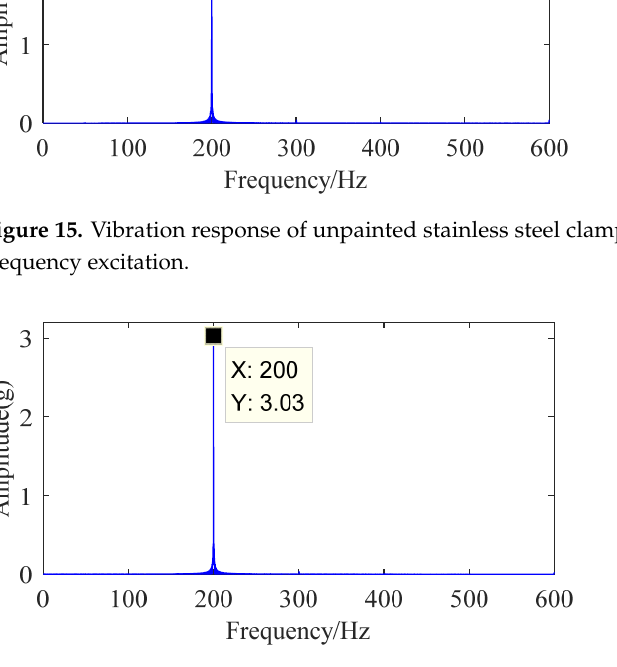
Figure 16. Vibration response of unpainted galvanized iron clamp and pipeline under 200 Hz fixed-frequency excitation.